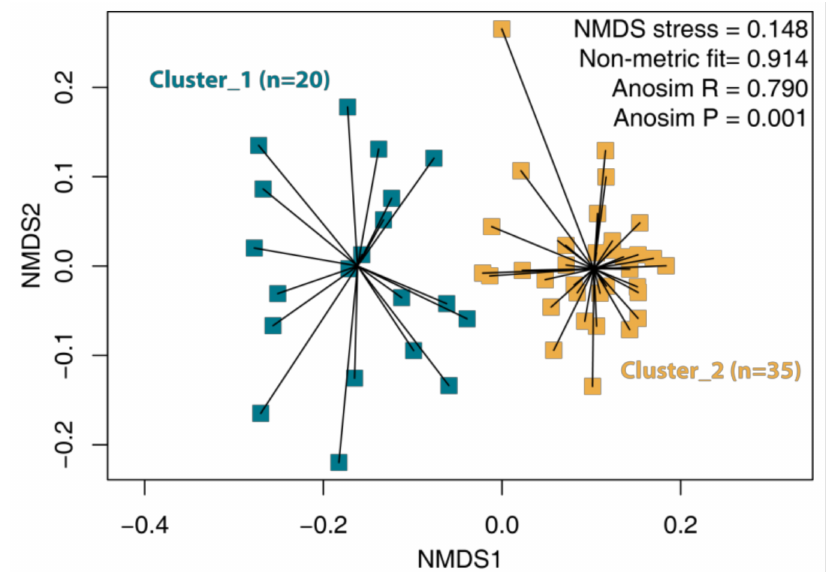
Figure 1. Nonmetric dimensional scaling (NMDS) scatterplot of semen samples acquired from clinically healthy breeding bulls. The samples were divided into two clusters according to the partition around a medoids (PAM)